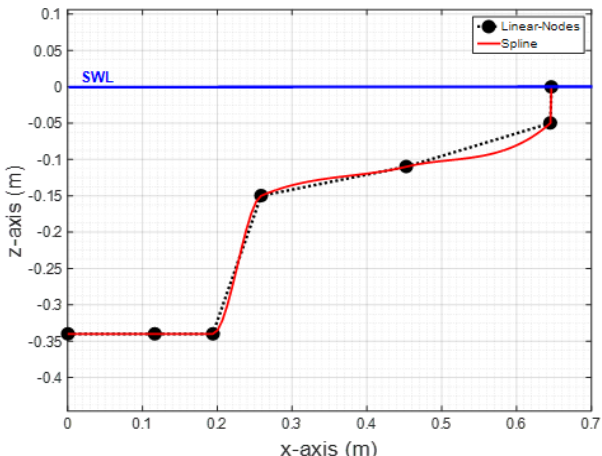
Figure 2. Generating spline of the nailhead-shaped WEC wetted surface.